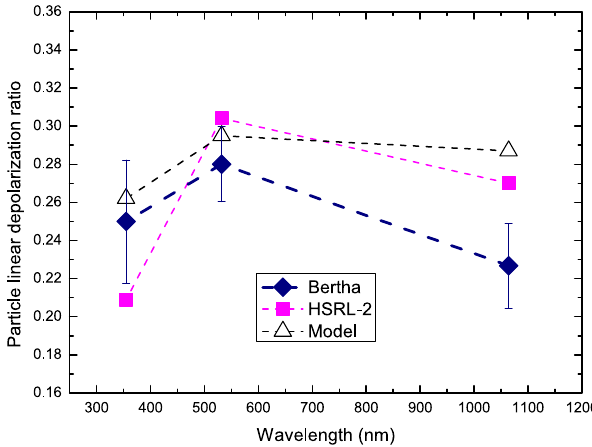
Figure 15. SALTRACE mean dust particle linear depolarization ra- tios at 355, 532, and 1064nm (SAL column mean values and corre- sponding standard deviations) measured with BERTHA (21